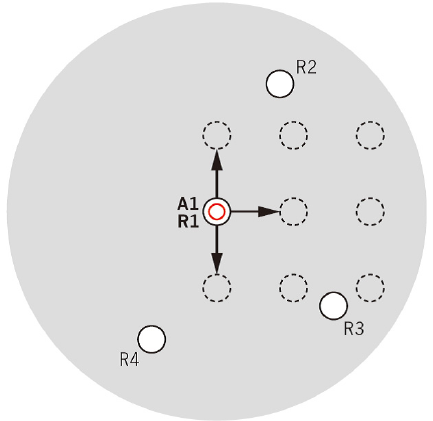
Fig. 4. Vectors of local information for a formation on the ant agent